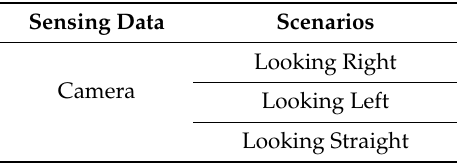
Table 3. Human sensing data scenario classification for building rules.